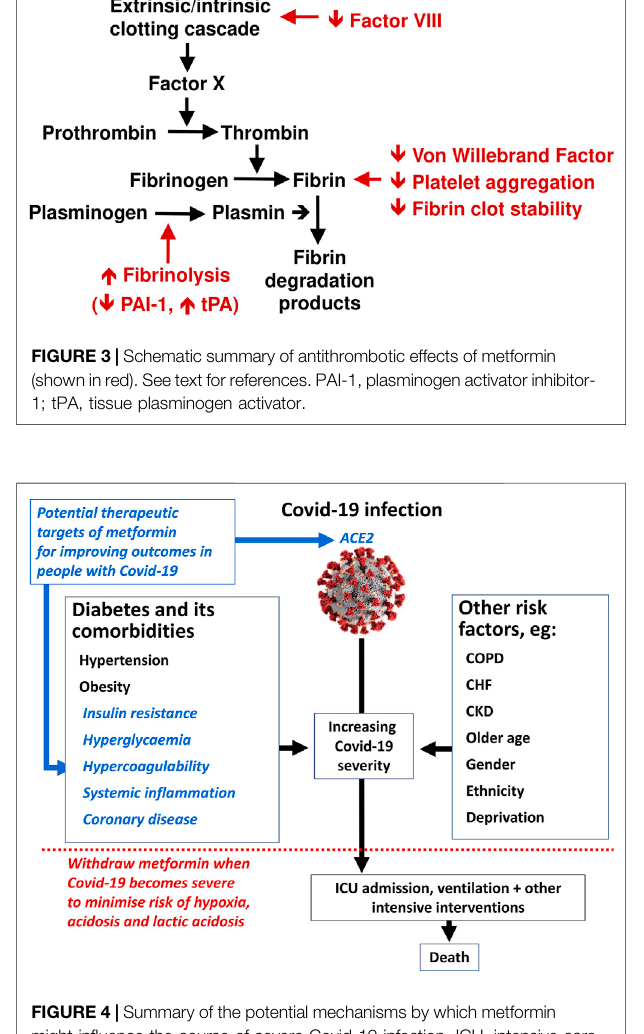
metformin reduced mortality before [OR 0.45 (0.25, 0.81), p =